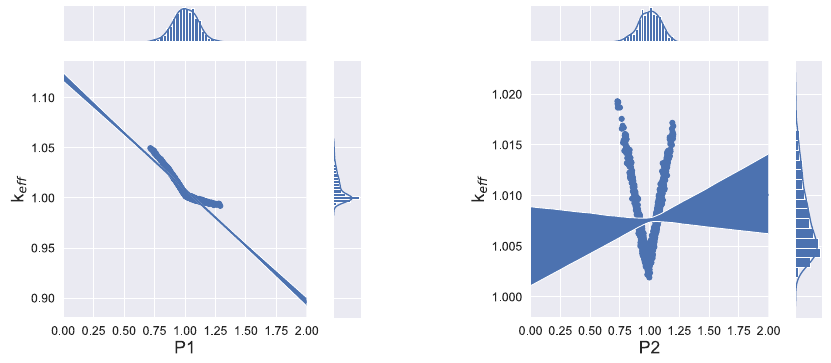
Figure 4: Estimates of the PMF6 k e ff sensitivity to the P1 and P2 coe ffi cients for elastic scattering in 238 U.